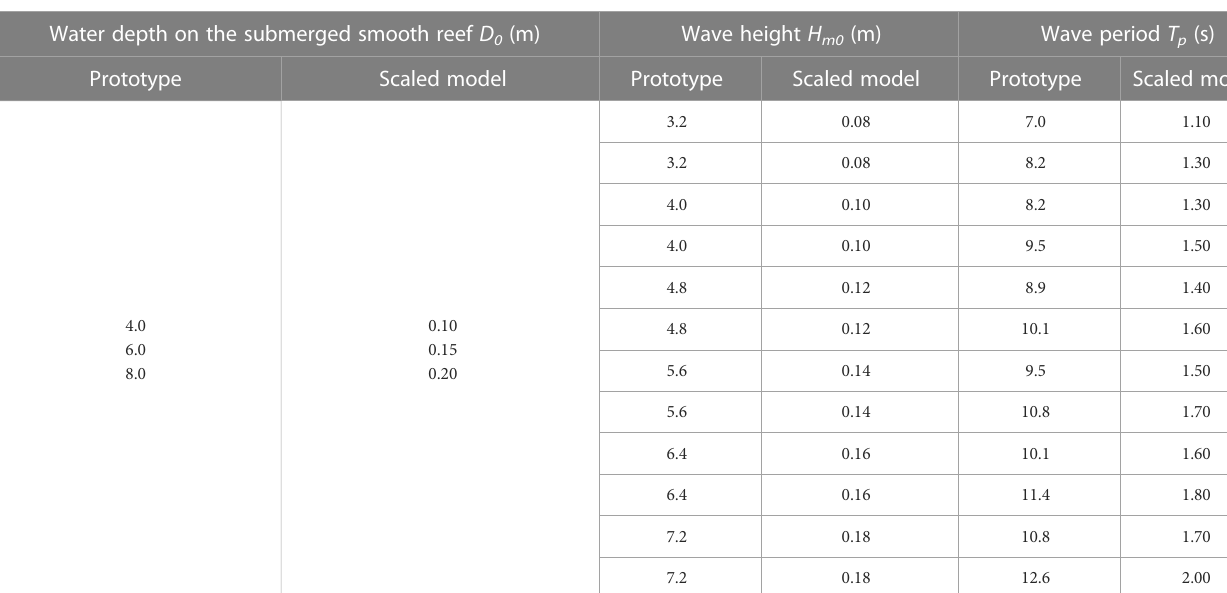
TABLE 2 Test cases for each submerged reef